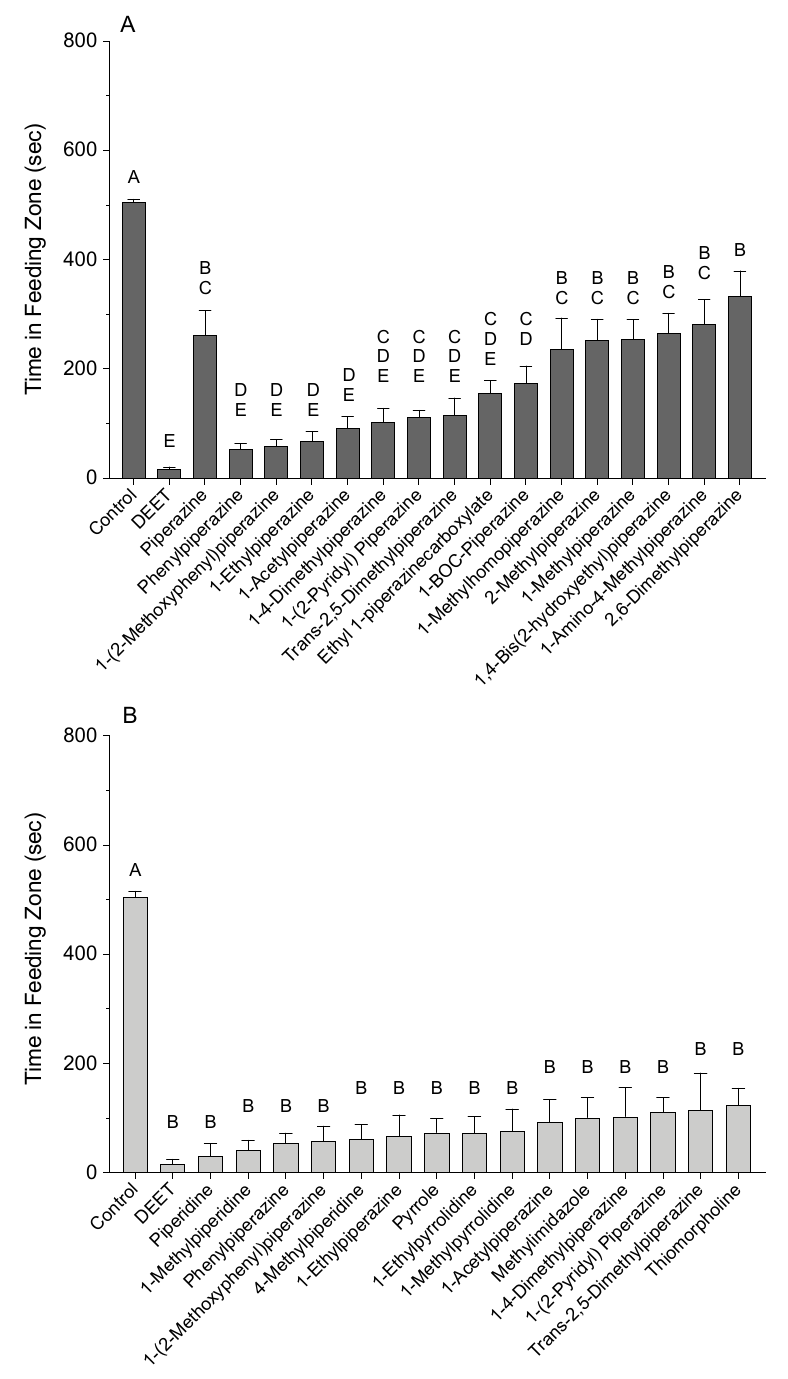
Figure 5. Effect of substituted piperazines on the feeding behavior of honey bees and summary plot of compounds with repellent activity statistically indistinguishable from DEET. A video-tracking protocol was used to screen individual bees in Petri dishes for behavior changes when exposed to sugar-agarose cubes treated with HCAs (10 µL/mL). Controls were sugar-agarose cubes with no treatment. DEET-treated sugar-agarose cubes were screened as a positive control. ( A ) Substituted piperazines. ( B ) Combined graph of HCAs that had deterrent effects similar to DEET. Vertical bars represent the mean ± standard error. Different letters above bars indicate significant differences using one-way ANOVA with Tukey’s post-hoc test ( p <